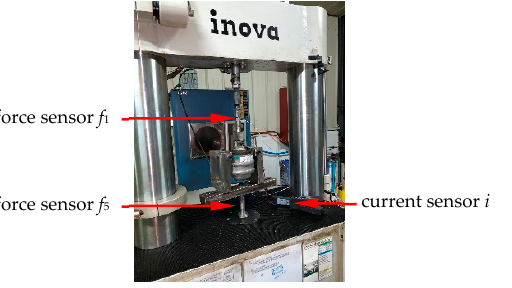
Figure 6. Experimental setup for active dynamics of an AHM-IT-DM-OCA in fluid-filled state.